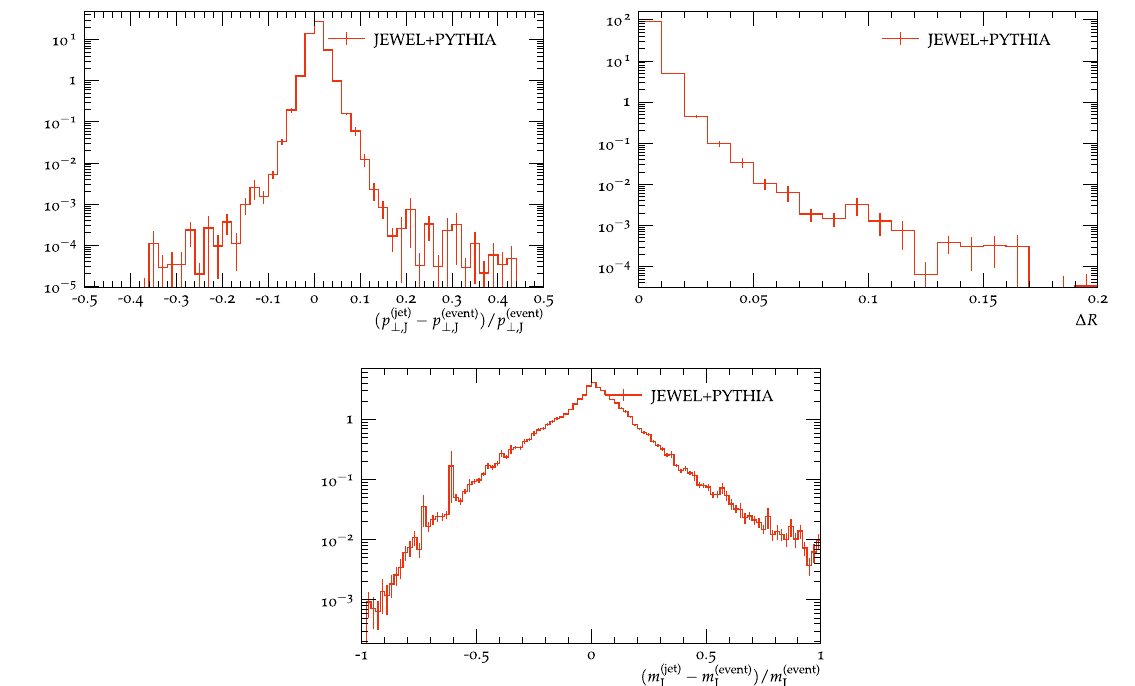
| η ( jet ) | < 2 . 5: relative difference in jet transverse momentum (top left), Fig. 3 Comparing event-wise and jet-wise subtraction for constituent (cid:3) ((cid:2)φ) 2 + ((cid:2)η) 2 betweenjetaxes(topright),andrelative background subtraction for the leading R = 0 . 4 anti- k ⊥ jet from angle (cid:2) R = √ ( jet ) > 100 GeV and mass difference s NN = 2 . 76 TeV with p a di-jet sample at ⊥